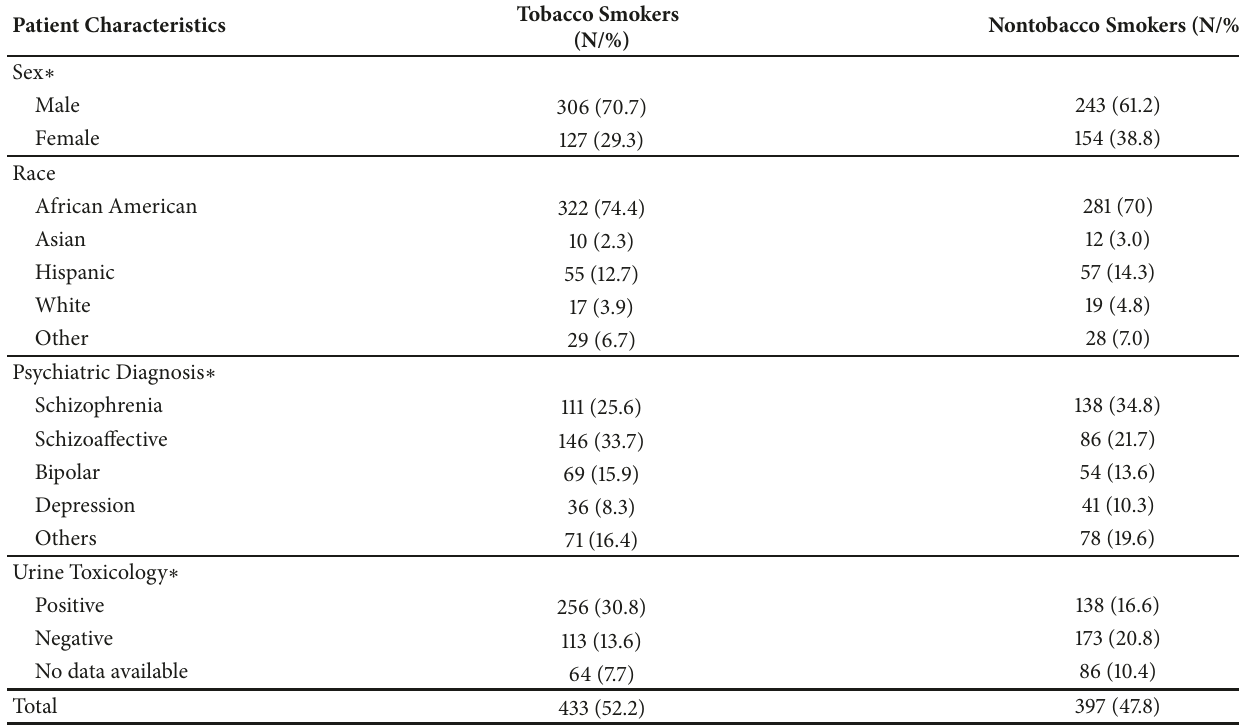
Table 1: Tobacco smoking status distribution according to demographic characteristics,primary psychiatric diagnosis, and urine toxicology. Patient Characteristics